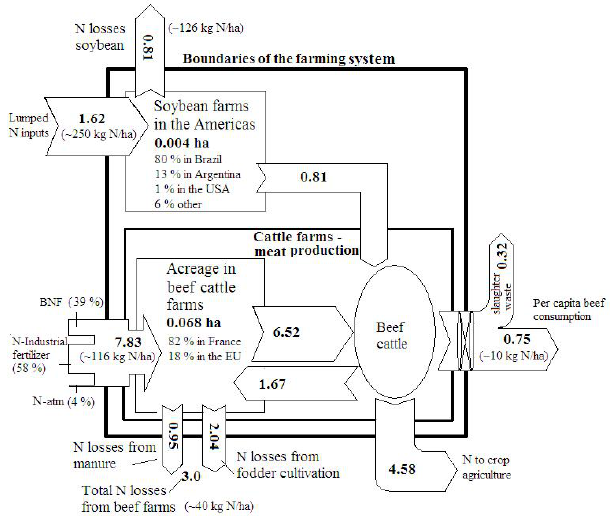
Fig. 8. Nitrogen and land requirements associated with the pro- duction of beef. Arrows (bold type) refer to per capita N flows (kgNcapyr − 1 ) and rectangles to per capita land requirements (hacap − 1 yr − 1 ) per country of feed production. N input and out- put per hectare are given in brackets (kgNha − 1 ).